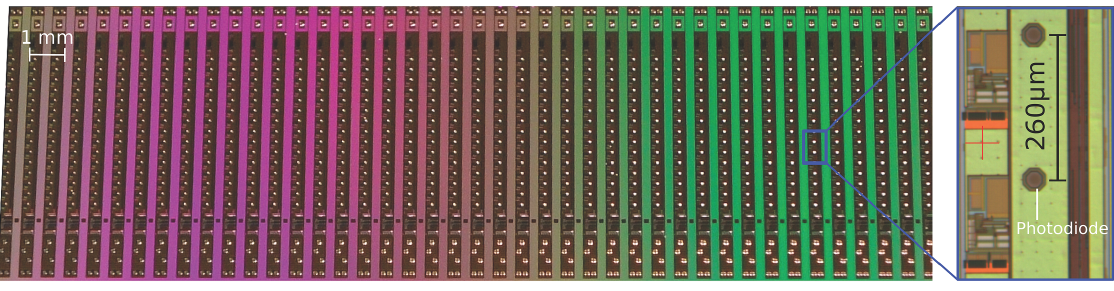
Figure 3. Image of the sensor die (see also the layout in Figure 2) having 42 independently-working columns comprising 15 photodetectors (pixels) each. As shown